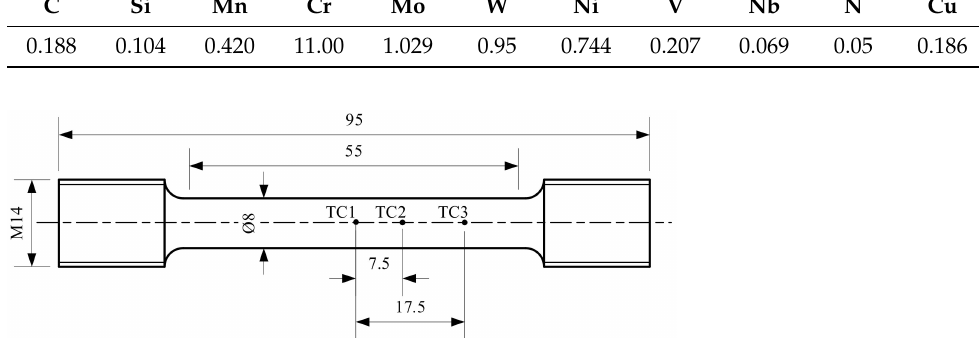
Figure 1. The size of hot tensile specimen and the welding positions of the thermocouple wires [mm].